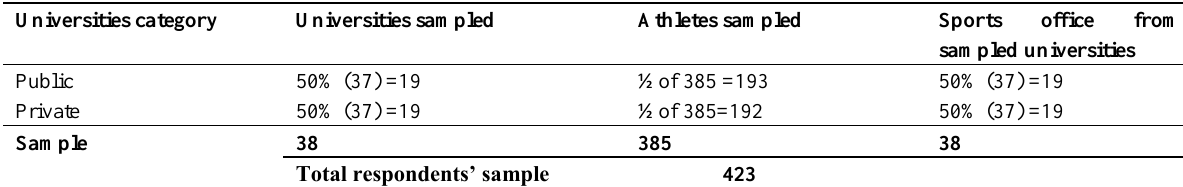
Table 1 Summary of the Sample Size